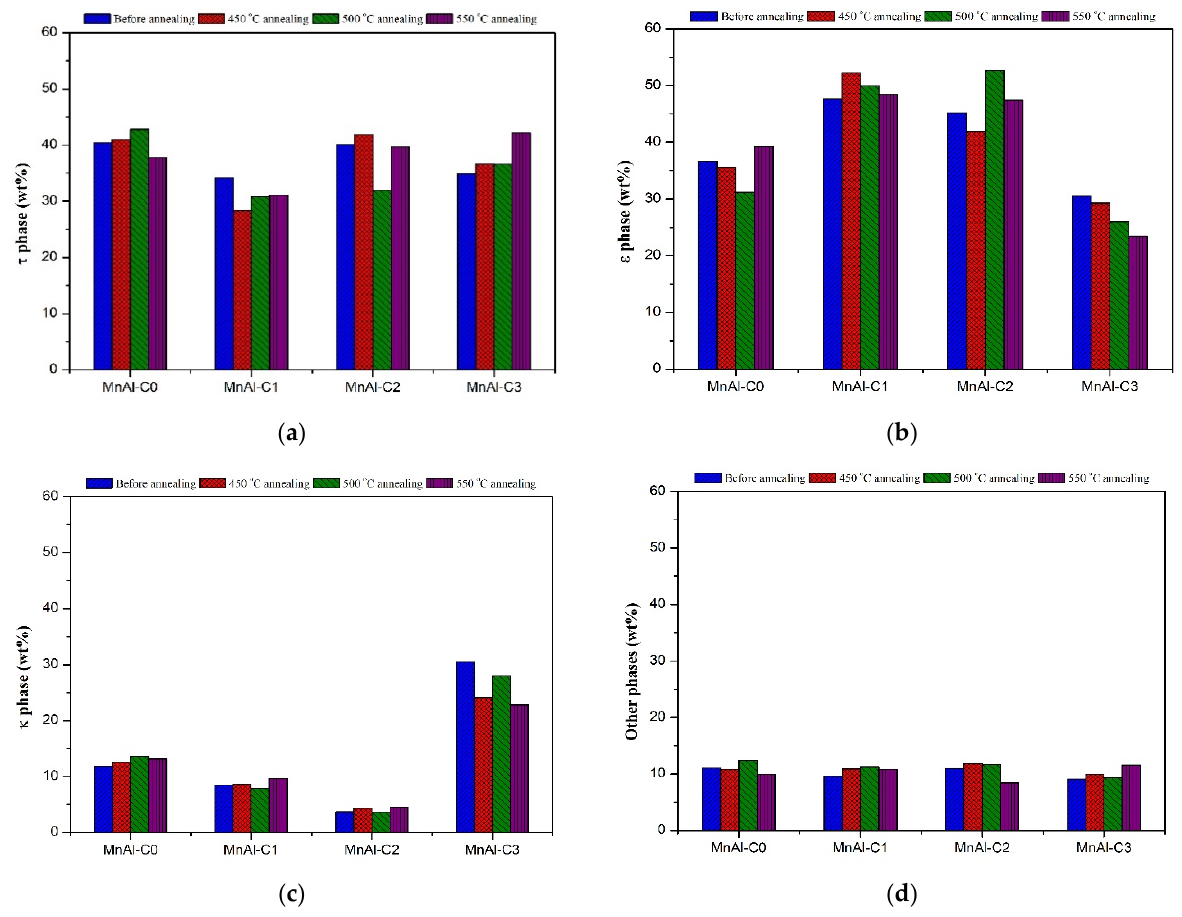
Figure 1. Weight ratio of ( a ) τ phase; ( b ) ε phase; ( c ) κ phase; ( d ) other remaining phases in (Mn 55 Al 45 ) 100-x C x powders computed from XRD spectra by the Rietveld refinement. After melting in the induction heating tube, MnAl–C0 (x = 0), MnAl–C1 (x = 1), MnAl–C2 (x = 2), and MnAl–C3 (x = 3) samples were annealed at 450, 500, and 550 °C for 20 min under argon atmosphere.